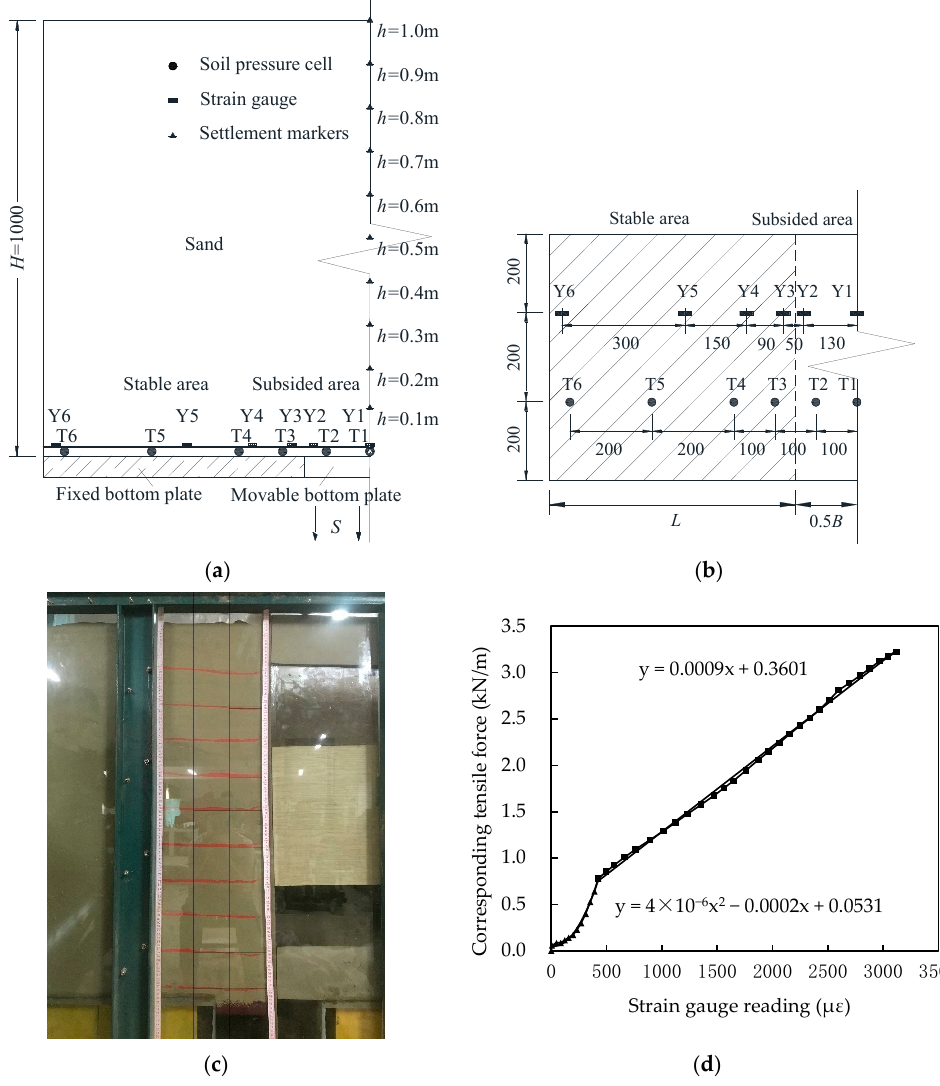
Figure 2. Placement situation of the monitor’s components: ( a ) vertical graph; ( b ) plane graph; ( c ) model test diagram (unit: mm); ( d ) strain-tensile force-strain curve by the gauge.